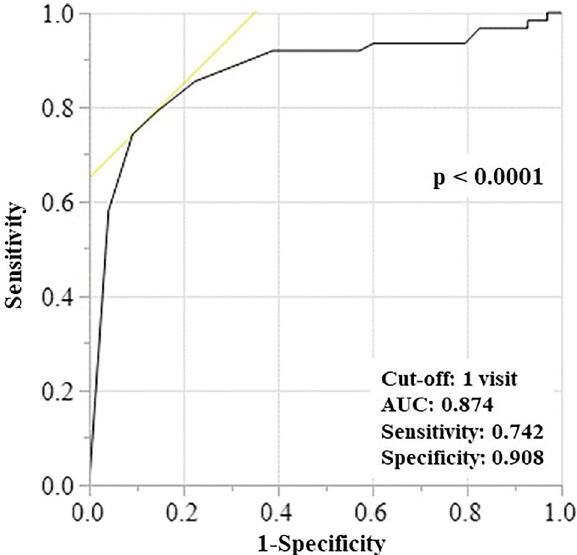
Figure 1. ROC analysis based on the visit time for CVC insertion at HD initiation. In this model, the cut- off value of visit time is 1; sensitivity and specificity were 74.2% and 90.8%, respectively; the AUC was 0.874, p < 0.0001. AUC, area under the curve; CVC, central venous catheter; HD, hemodialysis; ROC, receiver operating characteristic.